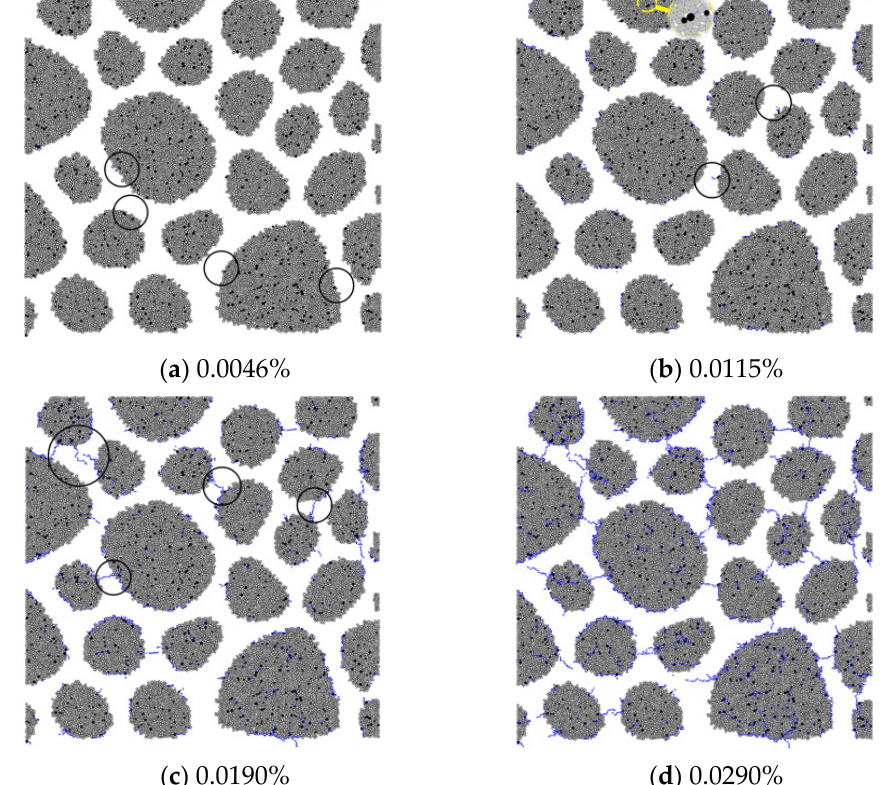
Figure 6. AAR-induced microcracks in GC40-1-5%.